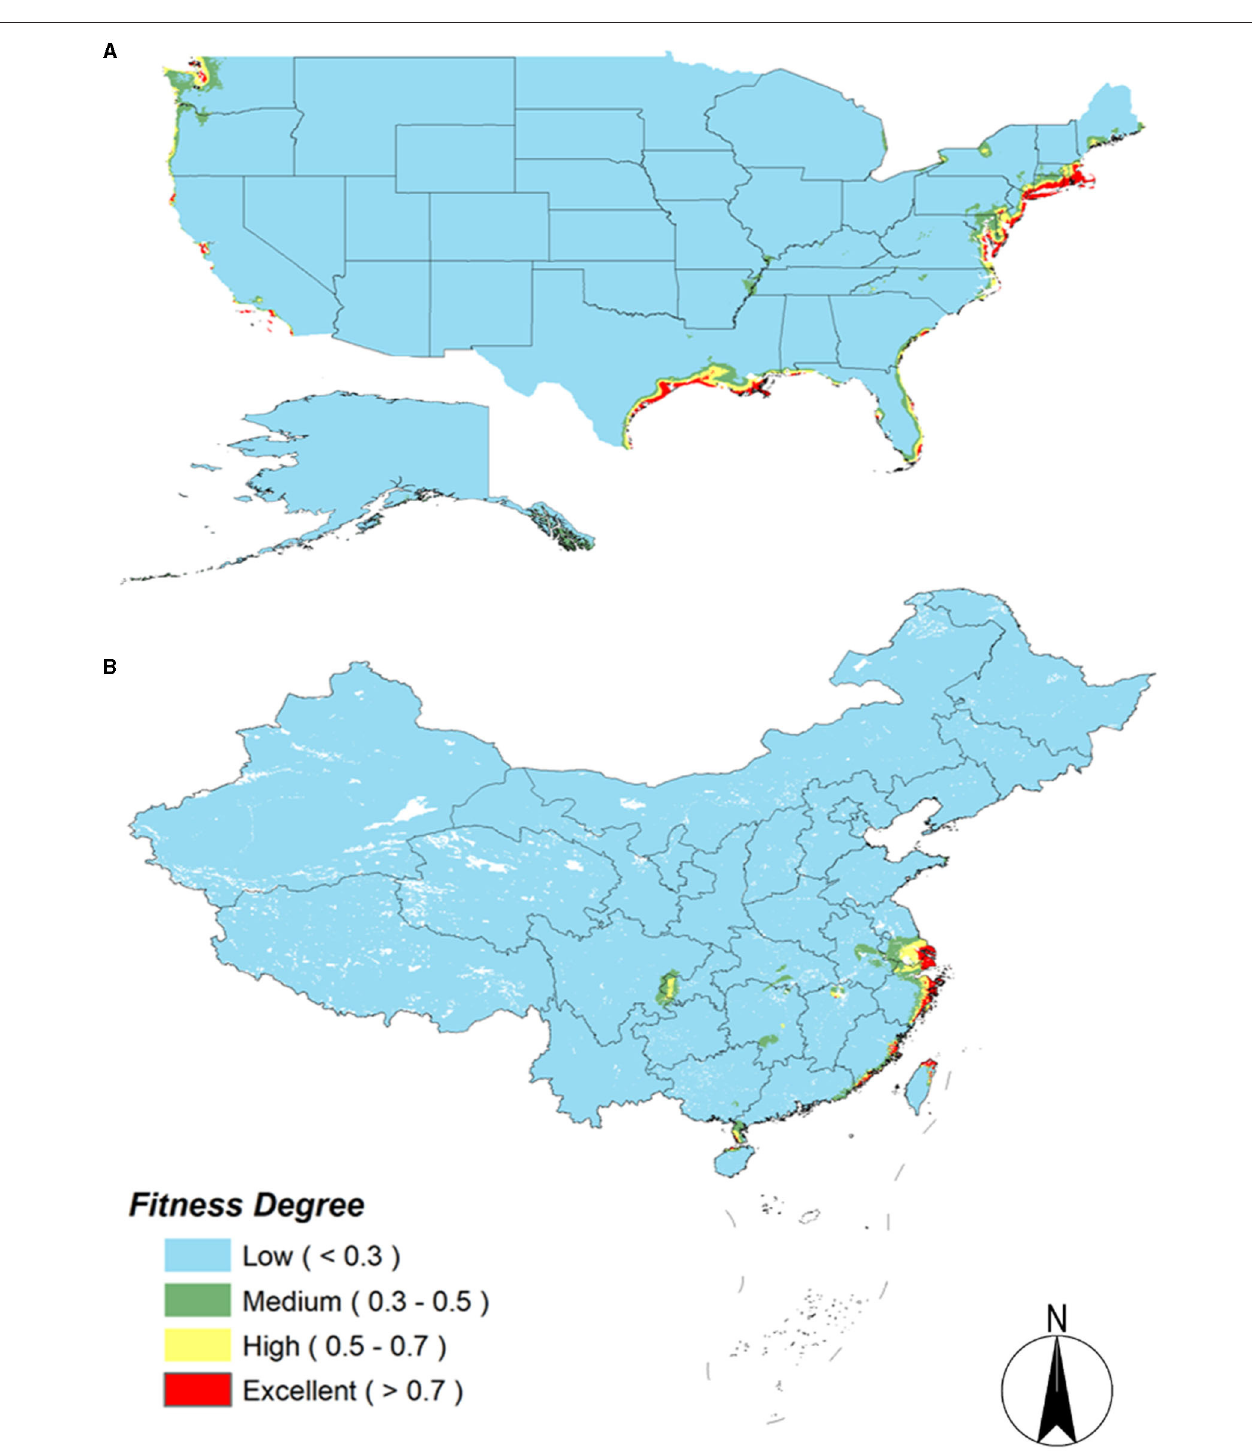
FIGURE 5 | Potential distribution of S. alterniflora in China and America. (A) America; (B) China.